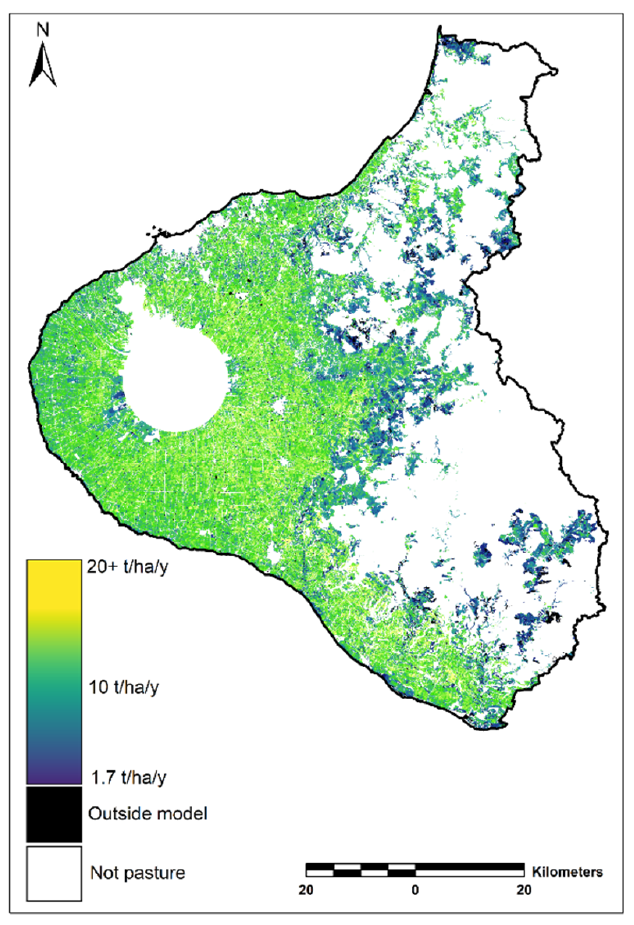
Figure 9. Taranaki pasture yield, with black areas having lower productivity than can be predicted by this model.